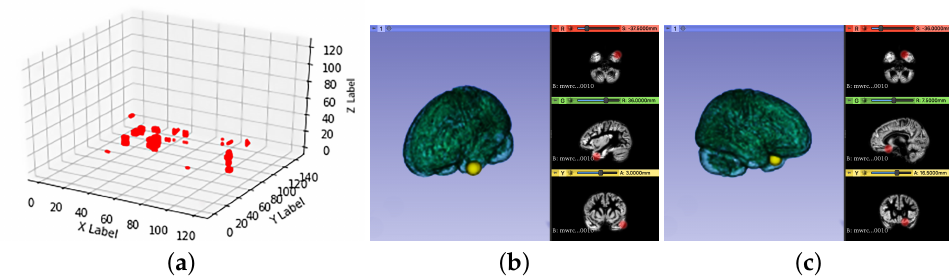
Figure 5. Visualization of the comment disorder region of eight patients. ( a ) in three-dimensional coordinate space; ( b , c ) two different suspected lesions in 3D and 2D